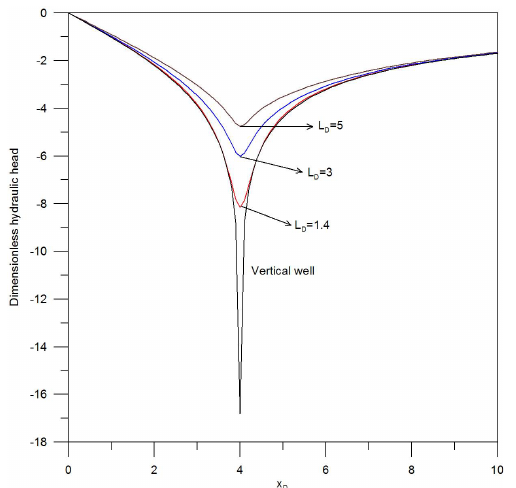
Fig. 8. The spatial head distribution for κ y = 1, κ z = 1, x 0 D = 4, z 0 D = 0 . 2, and various length of the horizontal well parallel to the stream.